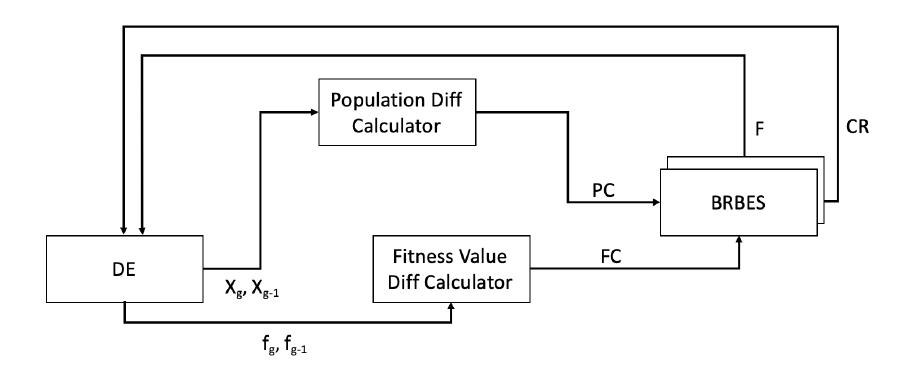
Figure 4. BRB adaptive Differential Evolution